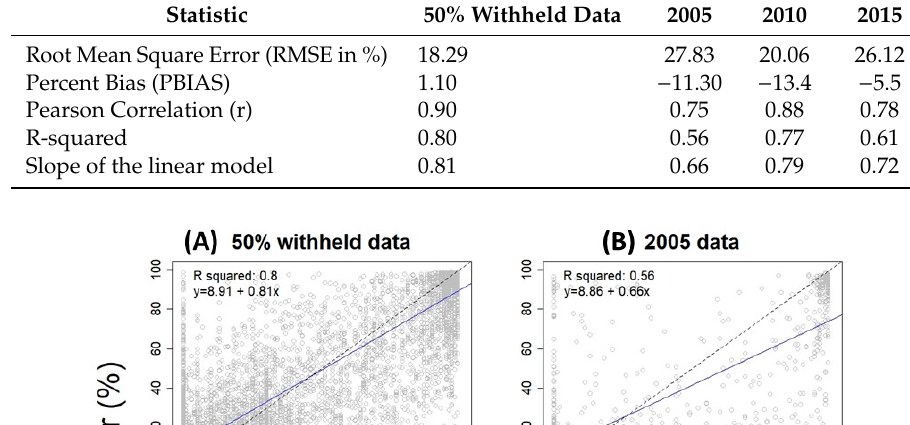
Table 2. Validation statistics for predictive tree cover model for the years 2005, 2010, and 2015 (N = 1000). Statistic